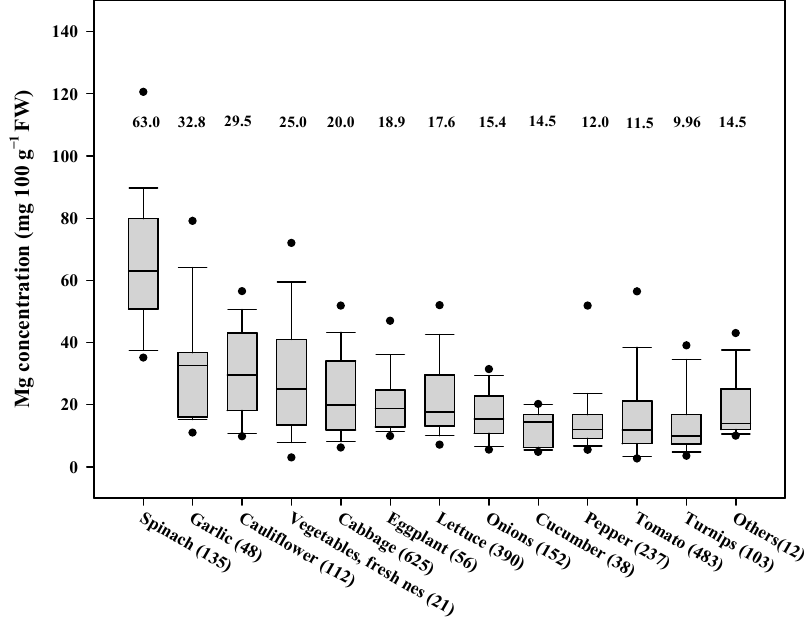
Figure 1. Mg content of major vegetables based on a global meta-analysis. The data represent mean values [expressed on fresh weight basis] with 95% bootstrap confidence intervals, and the sample numbers used for analysis are shown in parenthesis. The solid line passing through the box indicate median. According to FAO datasets, ‘Vegetables, fresh nes’ included in the figure represents: bamboo shoots ( Bambusa spp.), beets, chards ( Beta vulgaris L.), capers ( Capparis spinosa L.), cardoons ( Cynara cardunculus L.), celery ( Apium graveolens L.), chervil ( Anthriscus cerefolium L.), cress ( Lepidium sativum L.), fennel ( Foeniculum vulgare L.), horseradish ( Cochlearia armoracia L.), marjoram, sweet ( Majorana hortensis L.), oyster plant ( Tragopogon porrifolius L.), parsley ( Petroselinum crispum L.), parsnips ( Pastinaca sativa L.), radish ( Raphanus sativus L.), rhubarb ( Rheum spp.), rutabagas, swedes ( Brassica napus L.), savory ( Satureja hortensis L.), scorzonera ( Scorzonera hispanica L.), sorrel ( Rumex acetosa L.), soybean sprouts tarragon ( Artemisia dracunculus L.), watercress ( Nasturtium officinale L.). ‘Others’ included in the figure represents other vegetables that are not identified separately